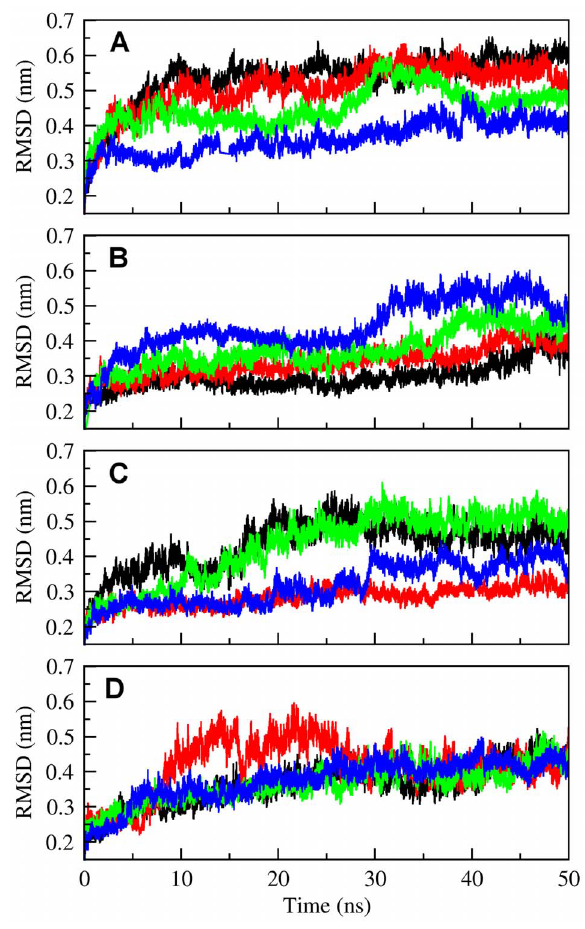
Figure 3. All-atom root-mean-square deviation (RMSD) of the protein, plotted against the 50 ns MD simulation time, for the systems containing (A) the NST alone and for the (B) NST/ PAPS, (C) NST/PAPS/ a -GlcN-(1 R 4)-GlcA and (D) NST/PAP/ a - GlcNS-(1 R 4)-GlcA complexes. Black, NST-1; Green, Lys614Ala; Blue, His716Ala, Red, Lys833Ala.